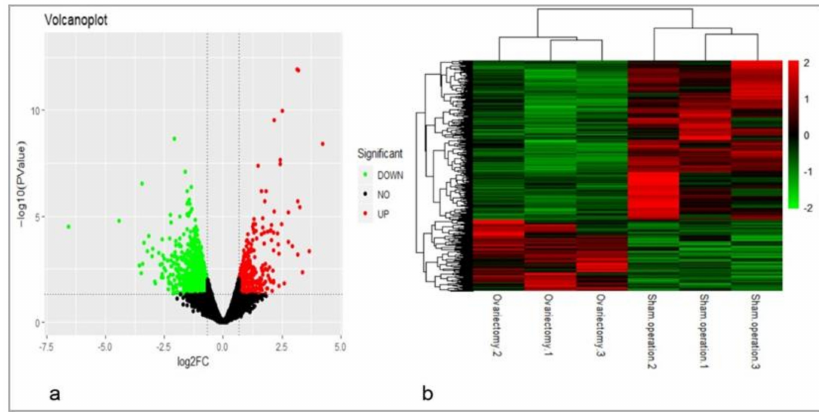
Figure 2. Volcano plot and cluster analysis of differentially expressed genes (DEGs). ( a ) Volcano plot. Red dots (UP) represent significantly up-regulated genes (log2 FC ≥ 0.58, p < 0.05); green dots (DOWN) represent significantly down-regulated genes (log2 FC ≤ − 0.58, p < 0.05); black dots (NO) represent DEGs below the level of significance; ( b ) based on 1461 known DEGs in the AF tissue of the ovariectomized and sham-operated groups at 14 weeks post-surgery, cluster analysis was performed. The results show that the data in the gene expression profiling of chickens in same group were closely related.